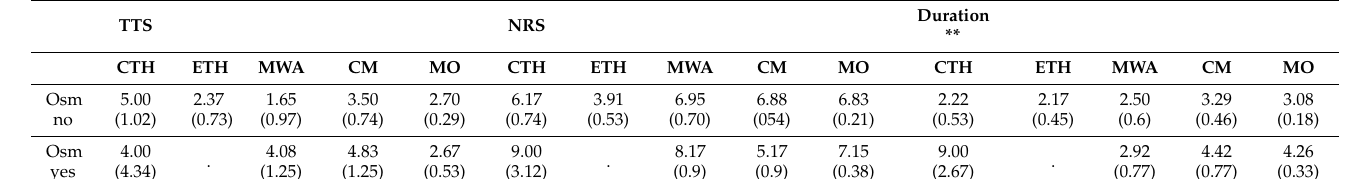
Table 2. Headache features in osmophobic and non-osmophobic headache children. In the ETH group, only one child reported osmophobia, so data were omitted. TTS: total tenderness score; NRS: numerical rating scale 0–10 for maximal headache intensity; ETH: episodic tension-type headache; CTH: chronic tension-type headache; MWA: migraine with aura; MO: migraine without aura; CM: chronic migraine. MANOVA for osmophobia F 3.34, p 0.019, for headache diagnosis F 6.76, p < 0.001; for interaction F 2.16, p 0.091. In detail, for osmophobia: headache duration ** F 9.55, p 0.002; for